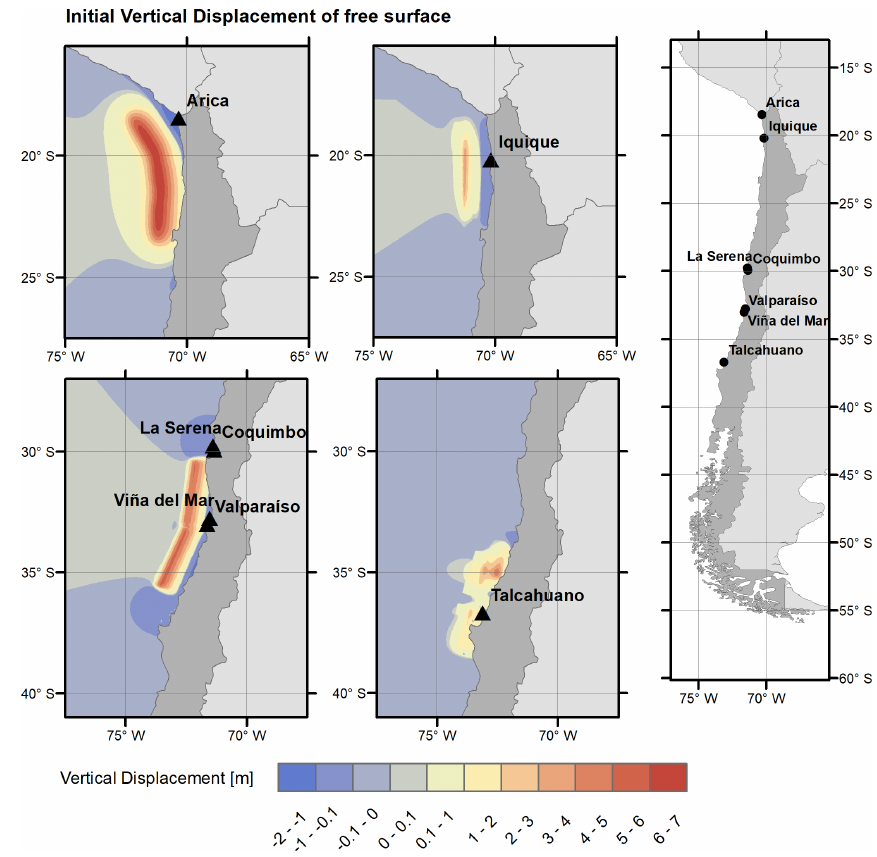
Figure 2. Seismic scenarios used for the examined case